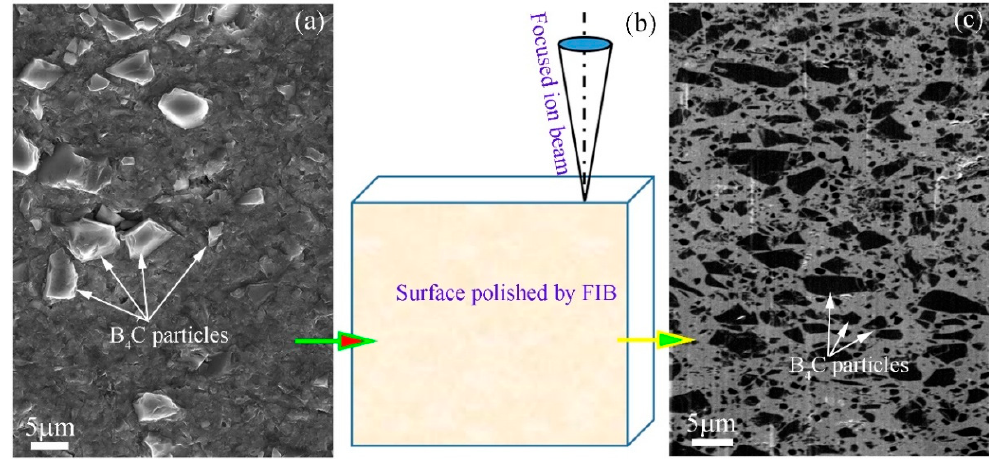
Figure 1. ( a , c ) SEM images showing the surface morphology of Al/B 4 C MMCs polished by the conventional metallographic method and focused ion beam technique, respectively; ( b ) The sketch of sample surface polished by focused ion beam.